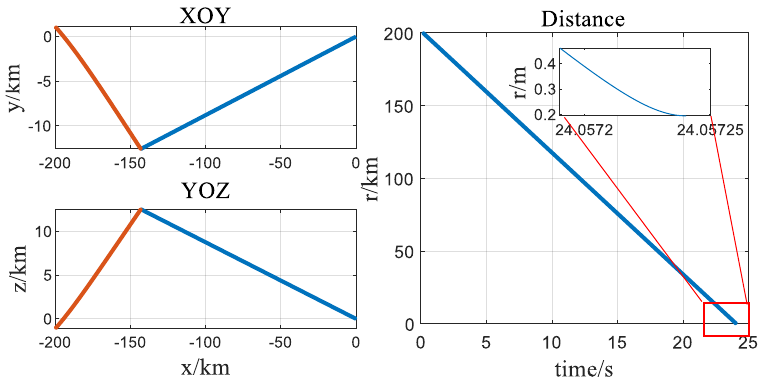
Figure 8. Evader employing a random maneuver.